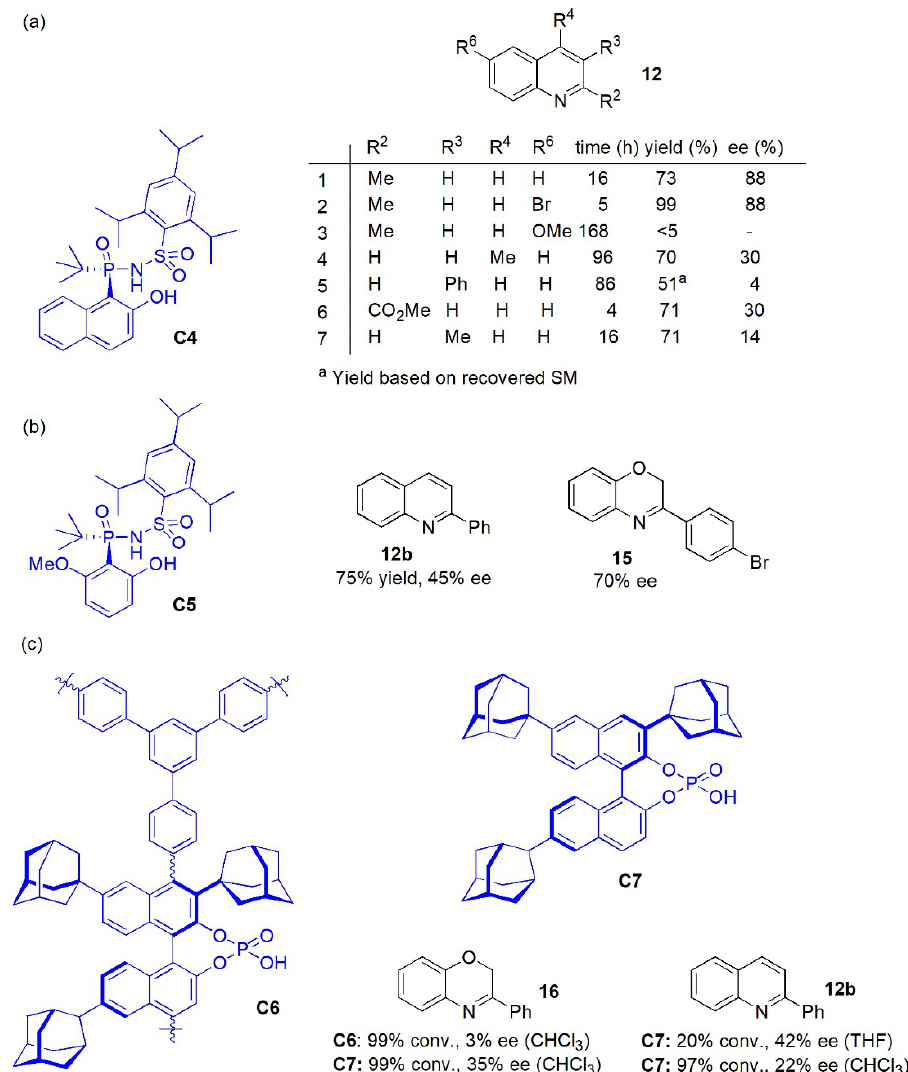
Figure 9. ETH of quinolines with chiral-at-phosphorus catalysts C4 ( a ) and C5 ( b ) and ( c ) with adamantyl-BINOL derived catalysts C6 and C7 [57].